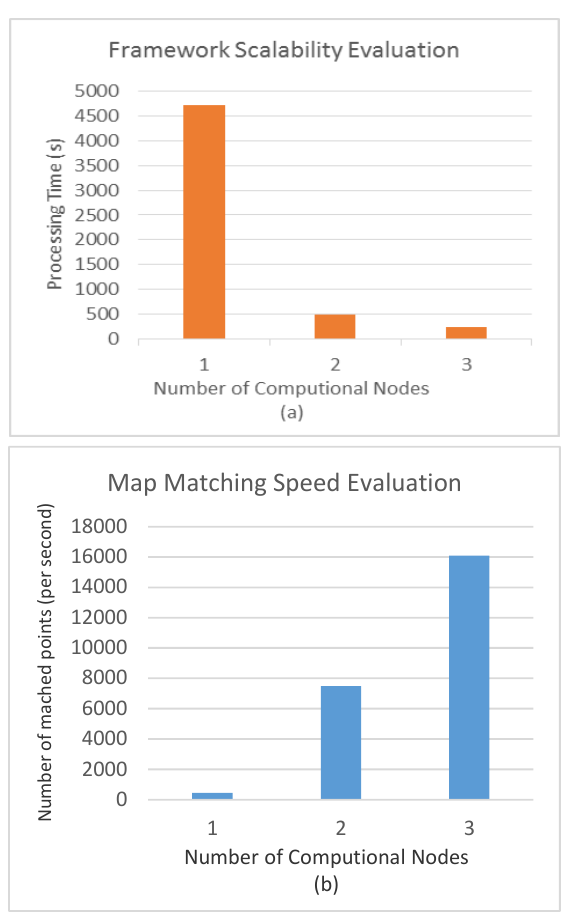
Figure 7. Computational layer